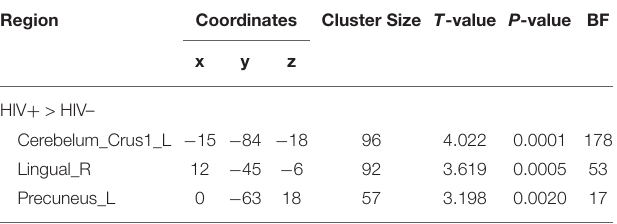
TABLE 3 | Functional connectivity differences between HIV + HoM and HIV– HoM. Region